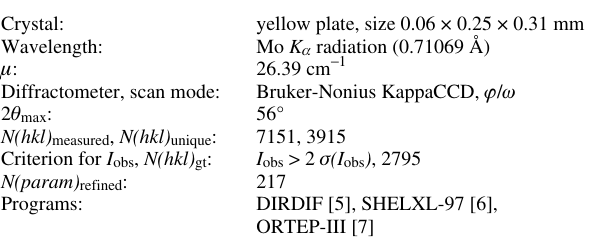
Table 1. Data collection and